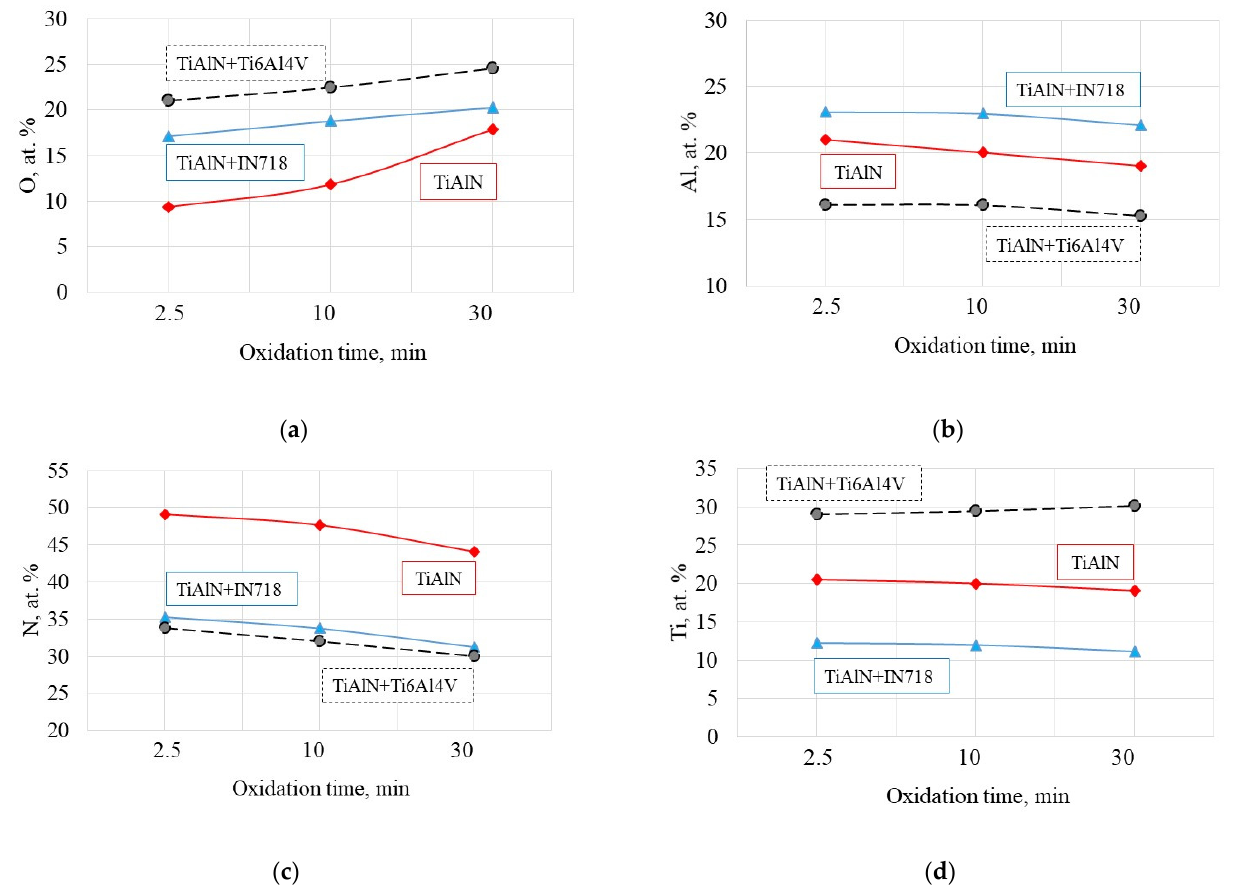
Figure 4. Average semi-quantitative chemical composition (estimated by EDS of oxidized layer for investigated samples: ( a ) oxygen; ( b ) aluminum; ( c ) nitrogen; ( d ) titanium. Process conditions: oxidation temperature of 900 °C, annealing times of 2.5 min, 10 min and 30 min. Table 2. The estimated chemical composition of oxidized layers deposited during oxidation tests of TiAlN coating.